Question: What caption would you write for this figure?
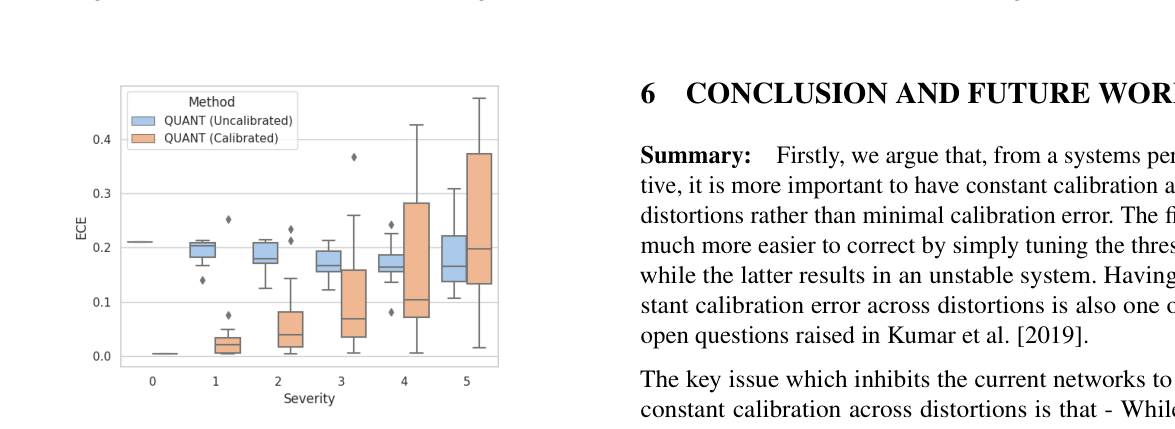
Answer: Correcting calibration error on the validation set may not improve performance on corrupted datasets.